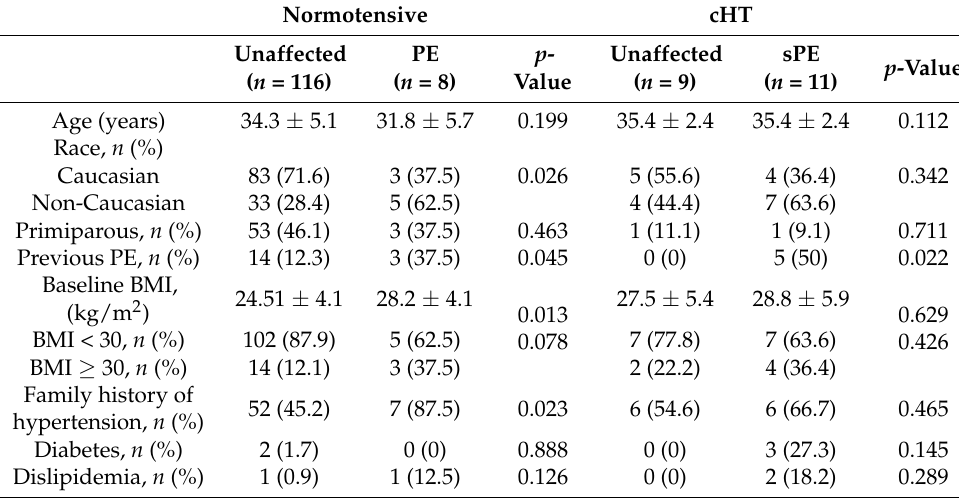
Table 2. Comparison of demographic and clinical characteristics between women with or without PE in the first